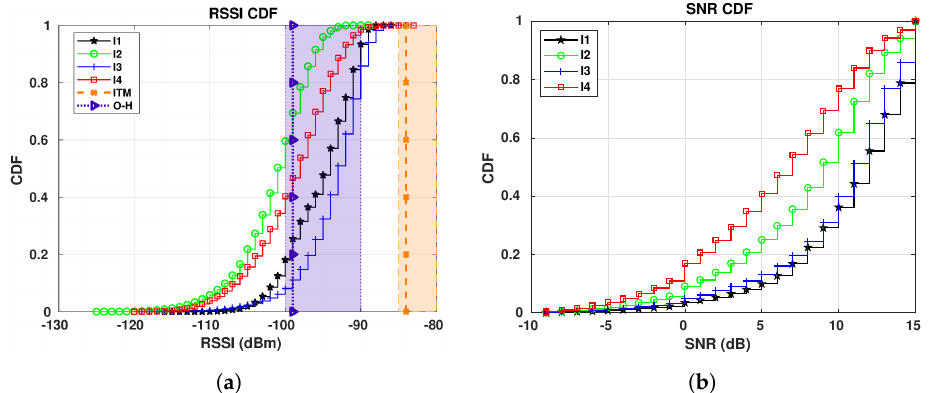
Figure 21. E1 RSSI and SNR CDFs for GW3: I1 (16/01/2019 to 07/02/2019): − 16.96 ◦ C on average; I2 (22/12/2018 to 06/01/2019): − 9.45 ◦ C on average; I3 (25/10/2018 to 04/11/20018): − 0.15 ◦ C on average; I4 (30/09/2018 to 14/10/2018): 6.56 ◦ C on average. ( a ) RSSI CDFs. ( b ) SNR CDFs.